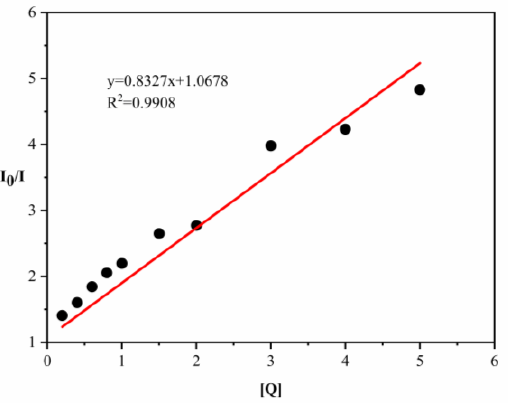
Figure 7. Stern-Volmer plots for the fluorescence quenching of CdTe QDs by C QDs.